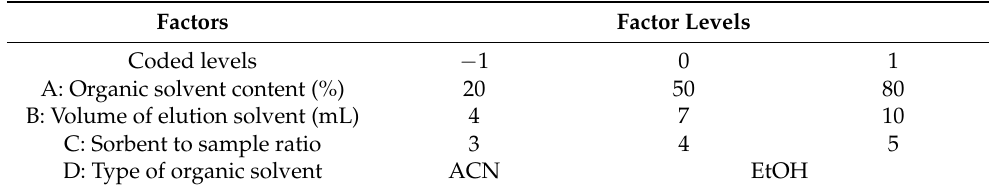
Table 4. Independent factors used and their levels in the BBD to optimize the MSPD